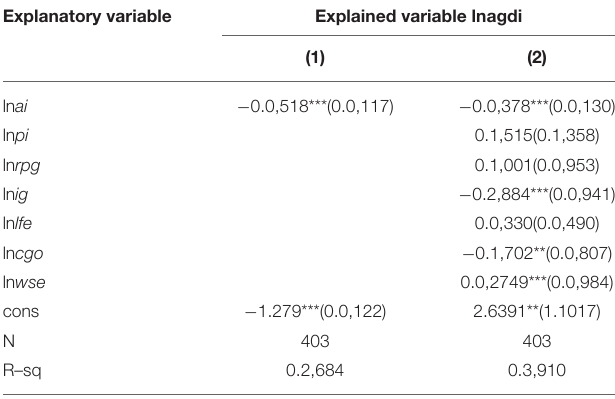
TABLE 6 | Full sample regression